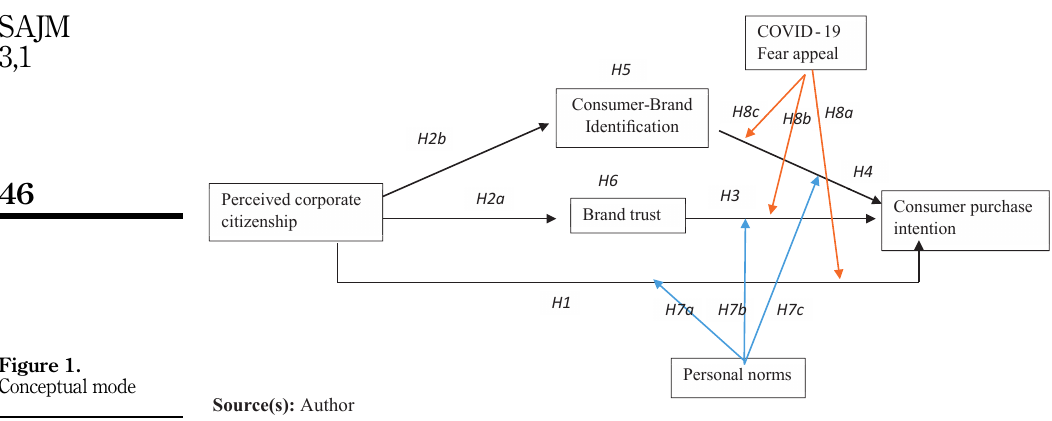
Figure 1. Conceptual